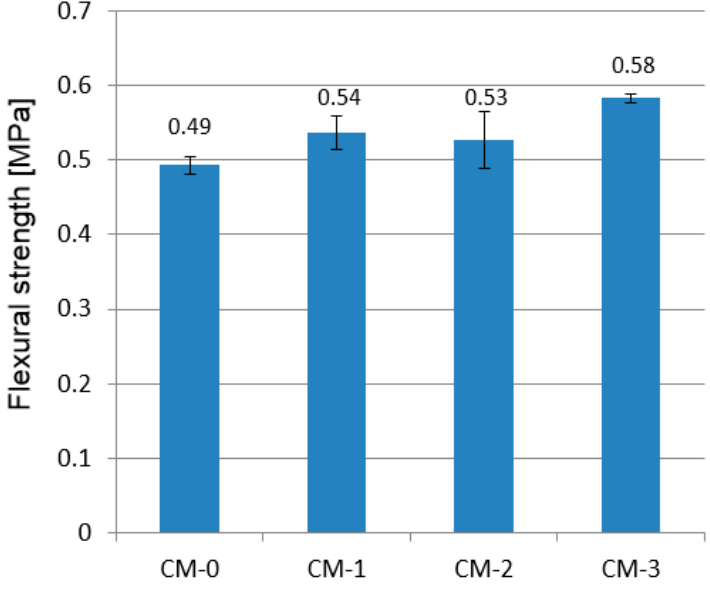
Figure 7. The average decrease in sample mass on individual days.